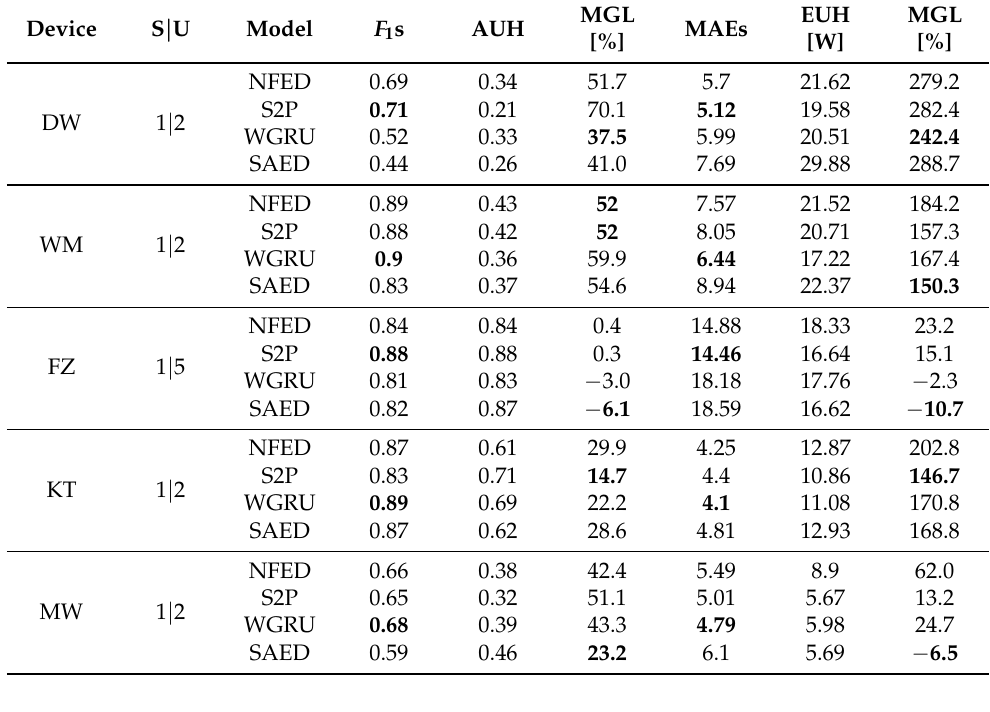
Table A1. Comparison of Classification and Estimation Accuracy between the models. Seen and Unseen houses are noted as S and U correspondingly. In the demonstrated case, AUH equals F 1